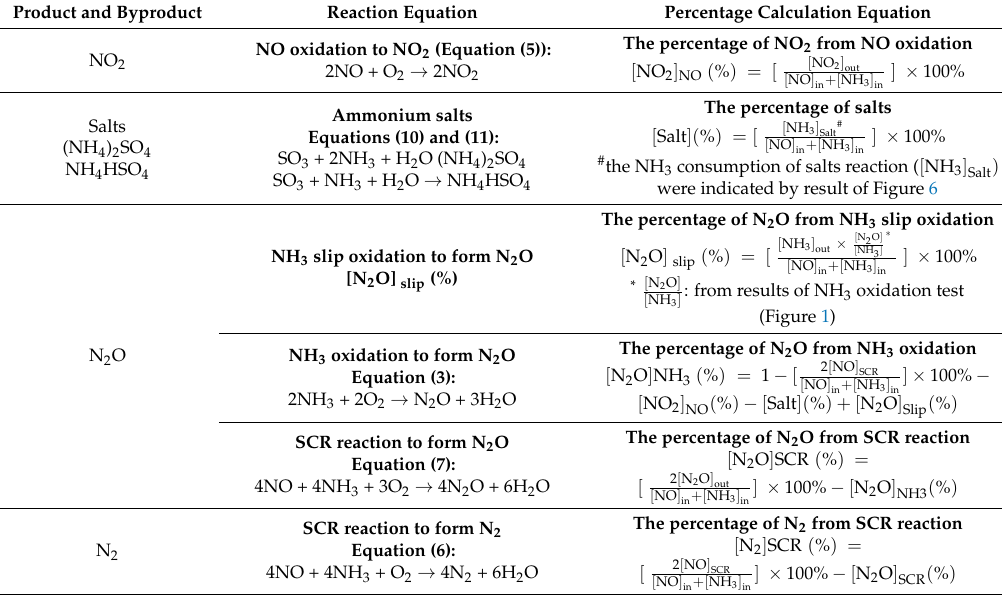
Table 2. Formulas for calculating the N-containing product and byproduct percentages during the SCR